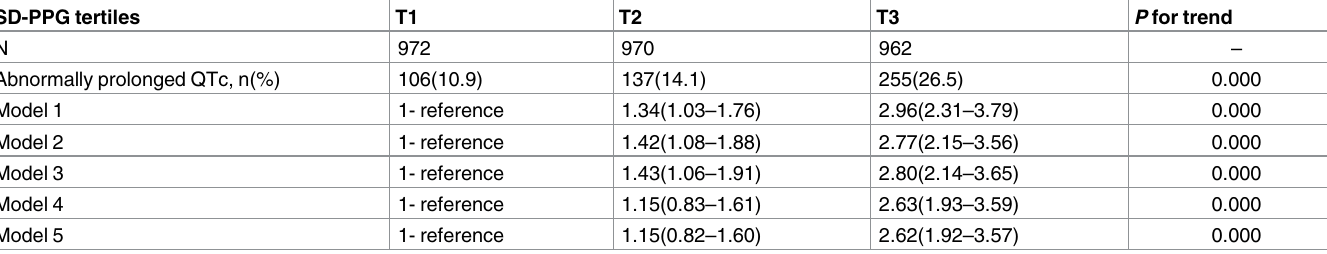
Table 3. Proportion and odd ratios (ORs) of abnormally prolonged QTc interval according to SD-PPG tertiles (95% CI). SD-PPG